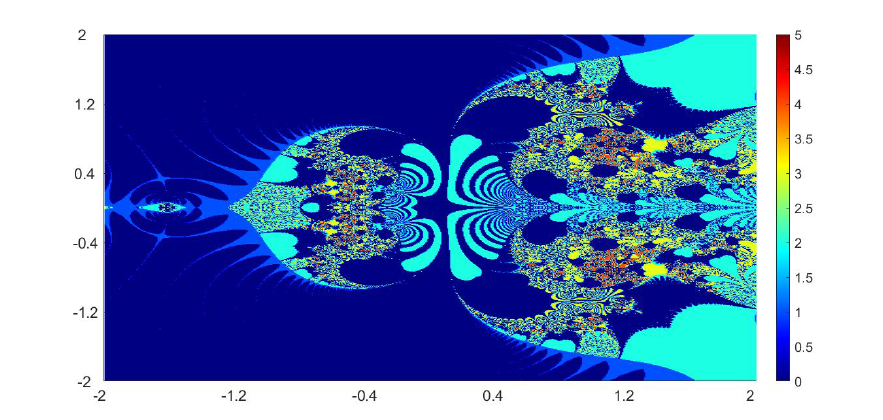
Figure 20. Example